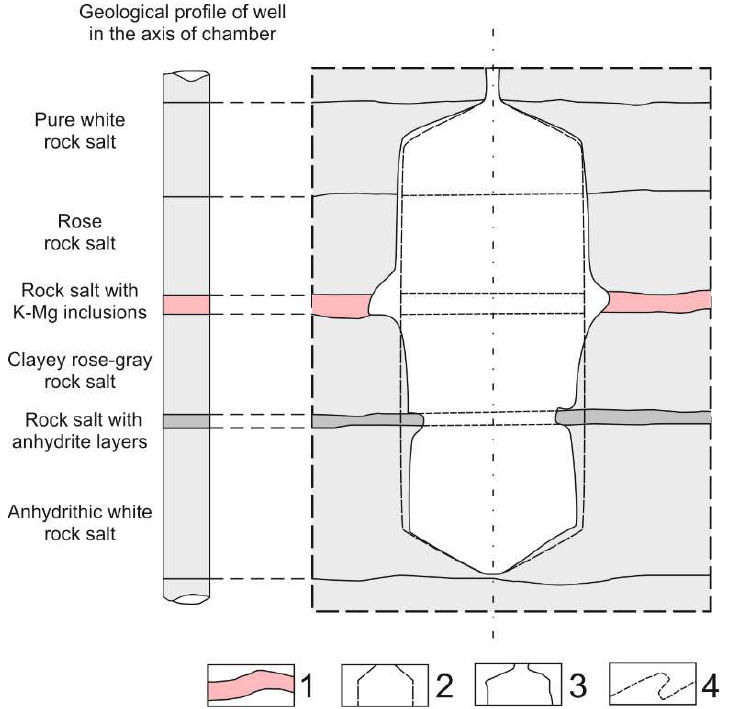
Figure 2. Influence of the arrangement of layers in the deposit on the development and shape of the leach chamber. 1—K-Mg salt layer, 2—projected shape of chamber, 3—obtained shape of chamber, 4—intersection lines of salt layers in the plane of the chamber [5]. Modified with permission from the publisher.